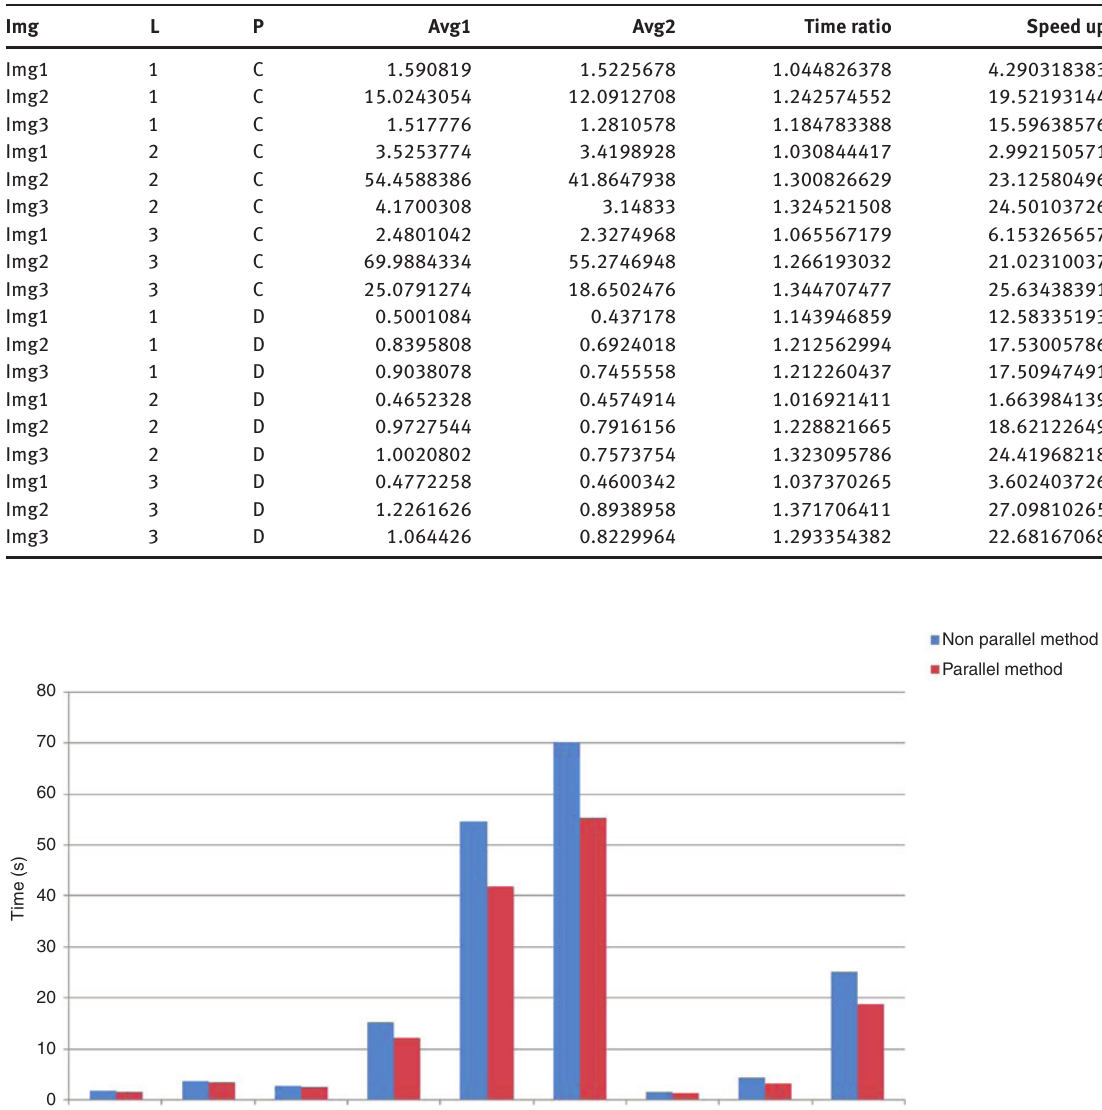
Table 8: Comparative Study of Both Parallel and Nonparallel Algorithms based on Compression Time.